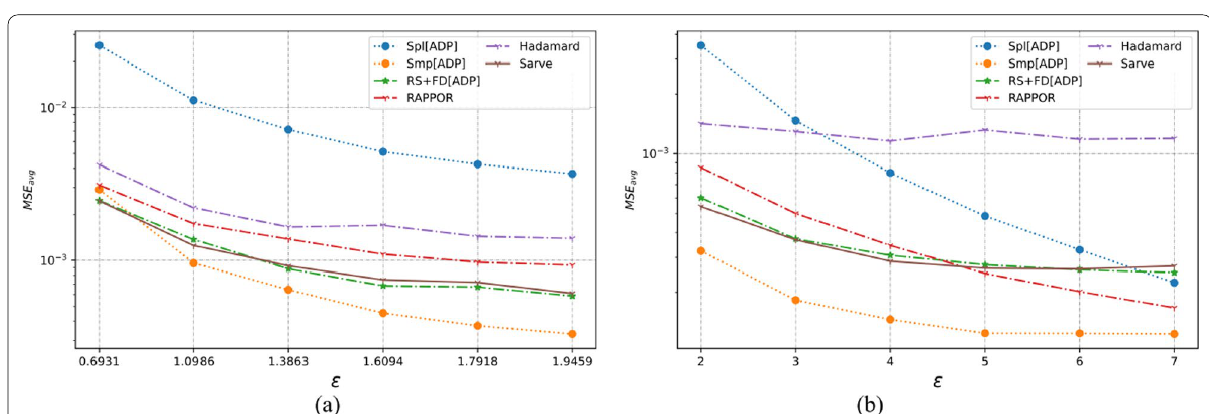
Fig. 6 The MSE averaged over 100 runs for the UCI nursery dataset privatized using different randomization techniques and fake data under a high privacy regime, experimental setup labeled ES_Real_2 in Table 1; b general privacy regime, experimental setup labeled ES_Real_5 in Table